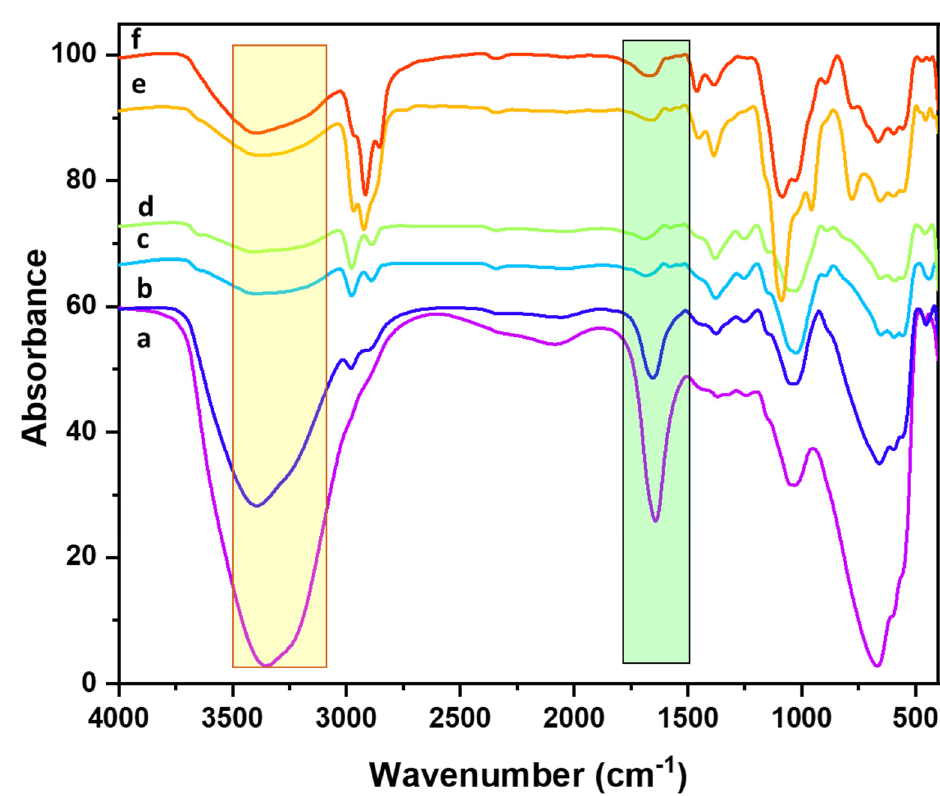
Figure 1. FTIR spectra of ( a ) Cell-F, ( b ) DA-Cell-F, ( c ) C1s-Ag-DA-Cell-F, ( d ) C4s-Ag-DA-Cell-F, ( e ) C8s-Ag-DA-Cell-F, and ( f ) C18s-Ag-DA-Cell-F.